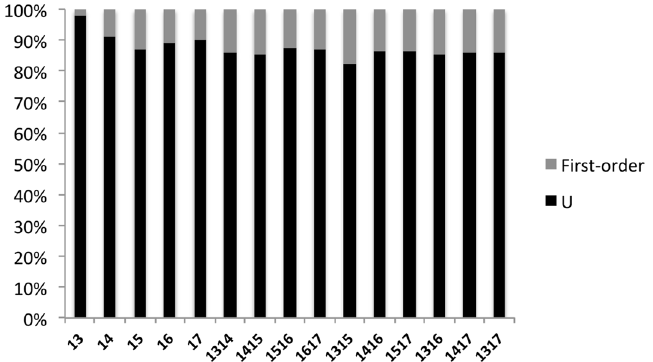
Figure 4. Bar charts of genetic relatedness based on pairwise genetic relatedness in each and between cohorts. (U = unrelated, First-order = PO + FS +